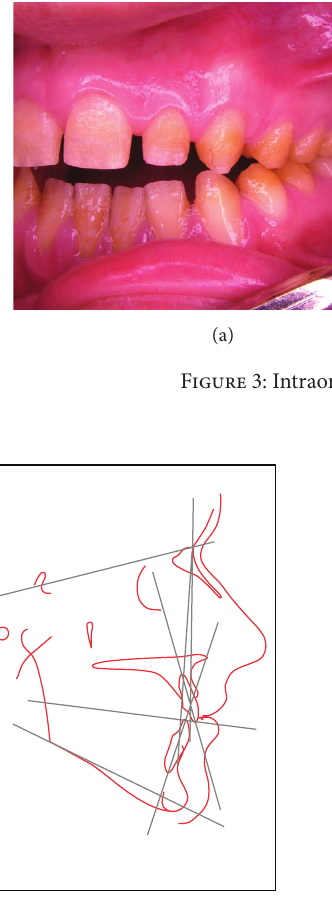
Figure 4: Cephalometric analysis of the